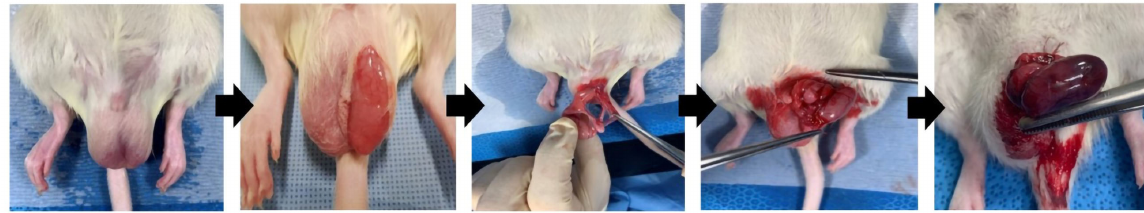
Fig. 1. Testicular torsion experiment. After the left scrotal incision, unilateral testicular torsion on the left is created by a 720 ◦ clockwise rotation, followed by fixation to the scrotal wall using a 4-0 silk